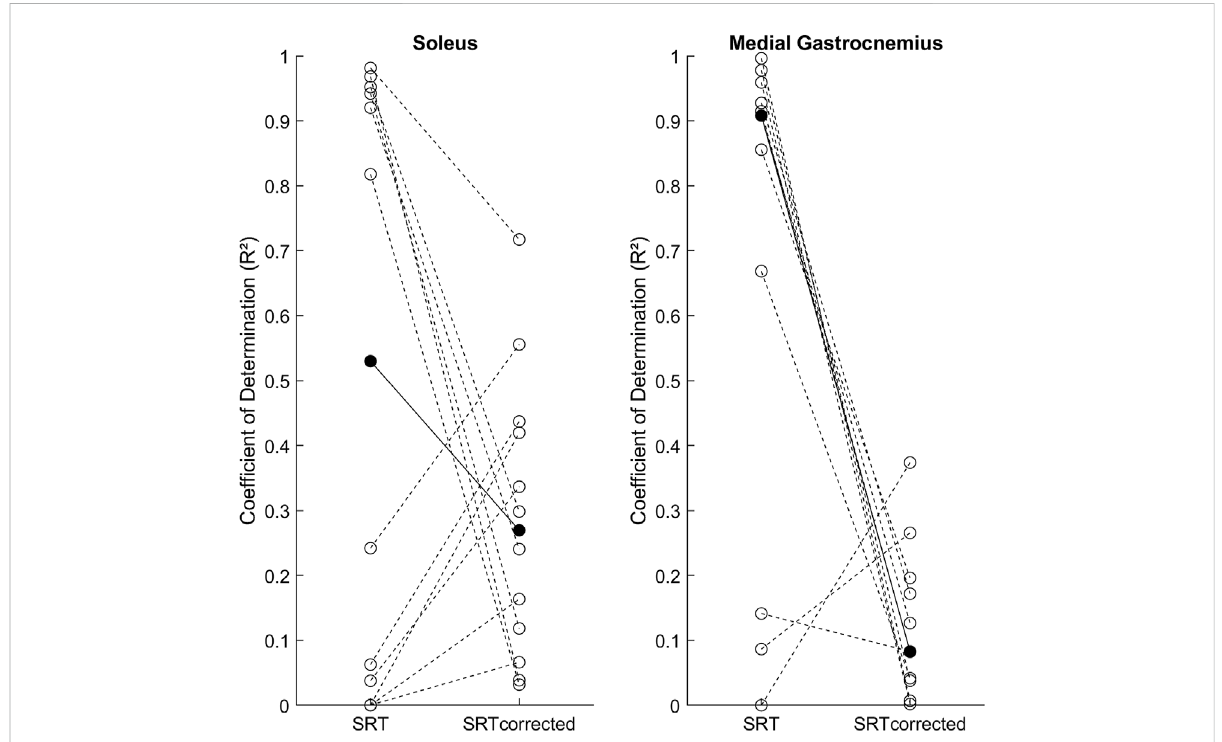
FIGURE 3 Individual SRT-velocity linear regression coef fi cients of determination ( R 2 , open circles) and group medians ( fi lled circles) for both methods: original (SRT) and latency corrected (SRT corrected